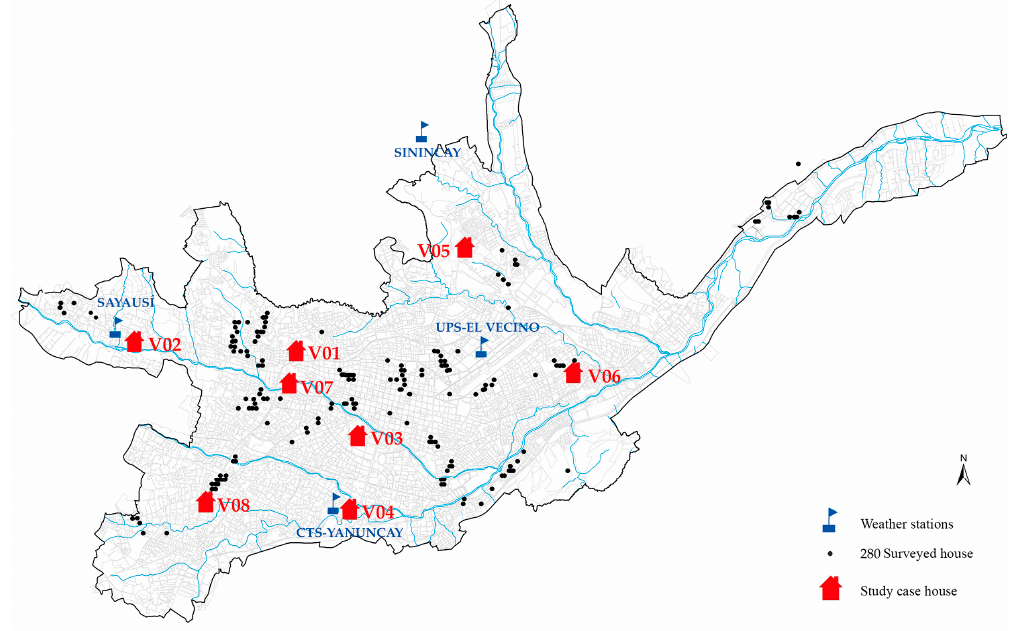
Figure 1. Location of houses and weather stations in Cuenca.